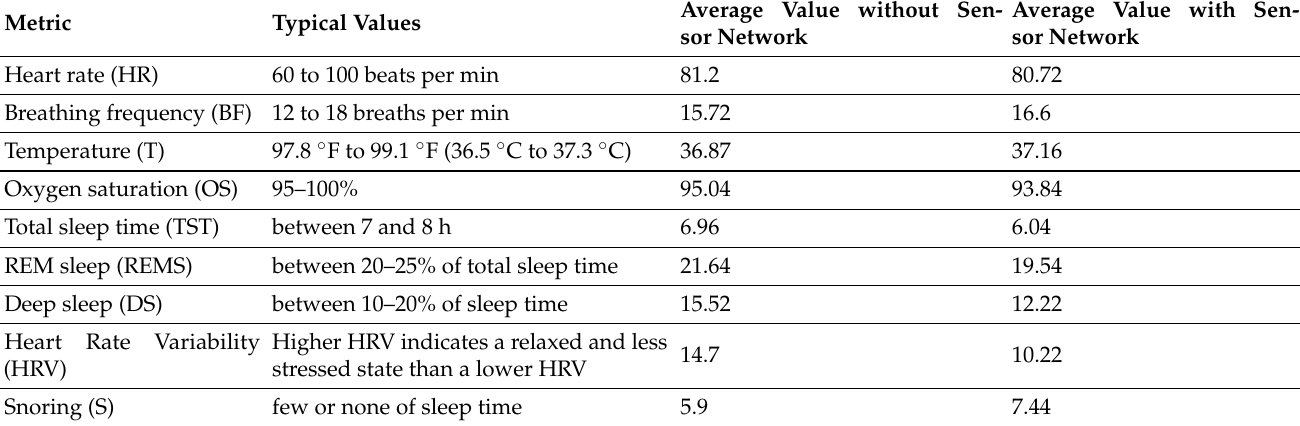
Table 5. Vital signs